Question: In one sentence, what is this figure communicating?
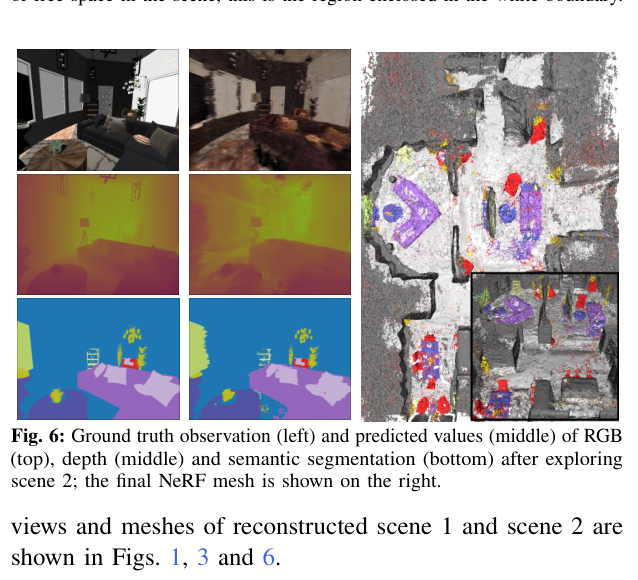
Answer: (right) shows the improvement in reconstruction qual- ity after active perception. Our method in general performs better in peak signal-to-noise ratio (PSNR) of synthesized RGB image, depth mean squared error (MSE), and cross entropy (CE) of pixel-wise classification.